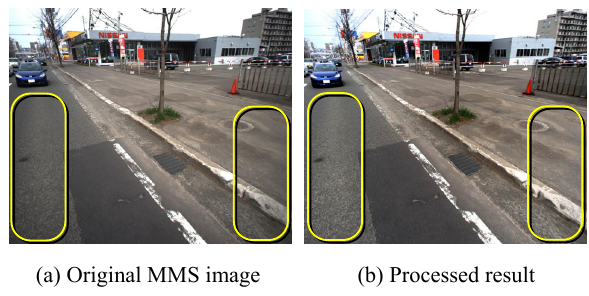
Figure 5. Effectiveness of peripheral brightness